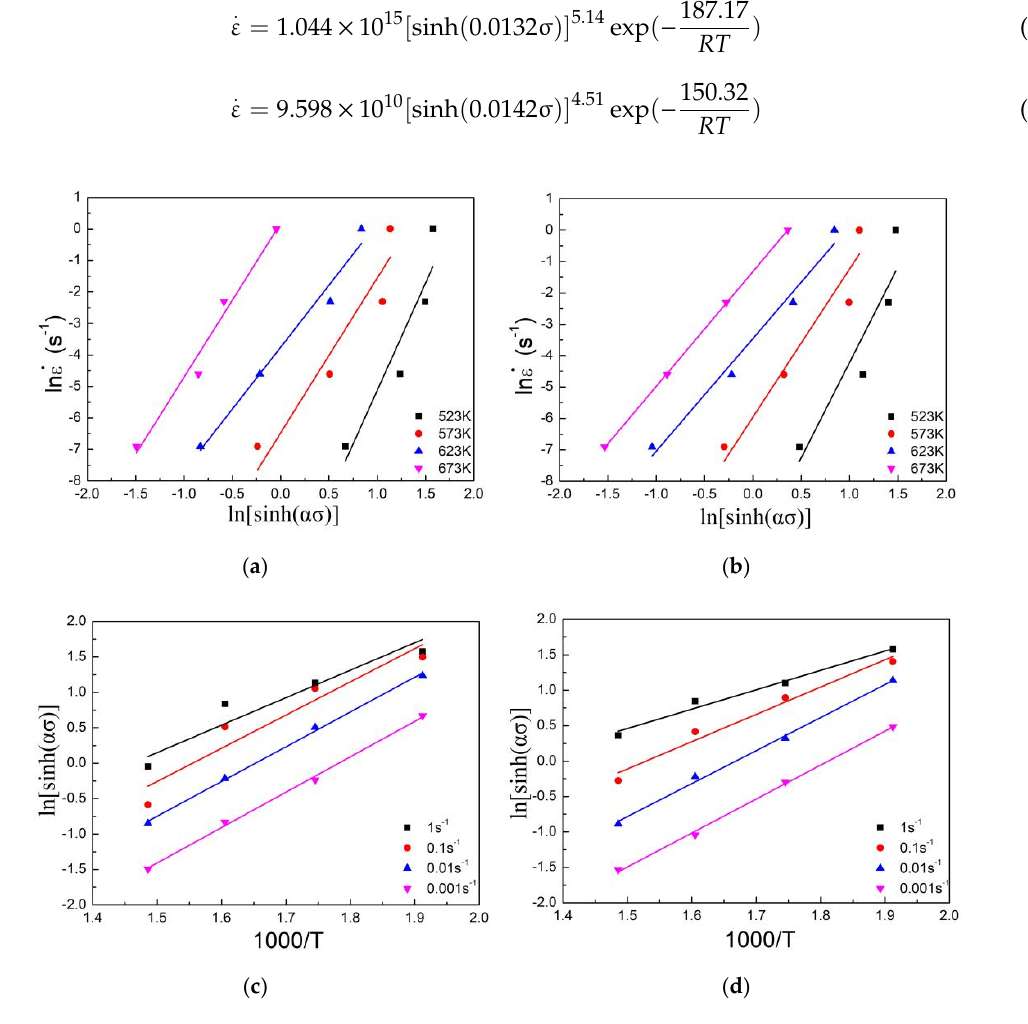
. ε Figure 4. Plots of ln  ε -ln[sinh( ασ )] ( a , b ) and ln [sinh( ασ )]-1000/ T ( c , d ) for MZC ( a,c ) and MZCM Figure 4. Plots of ln -ln[sinh( ασ )] ( a , b ) and ln [sinh( ασ )]-1000 / T ( c , d ) for MZC ( a , c ) and MZCM ( b , d ( b,d ).